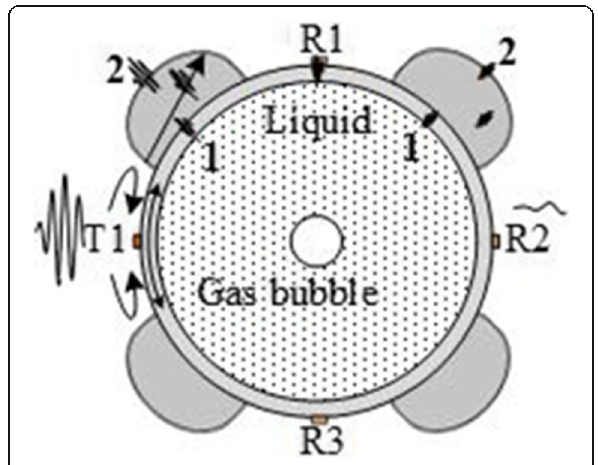
Fig. 3 A physical model and working principle of shielding